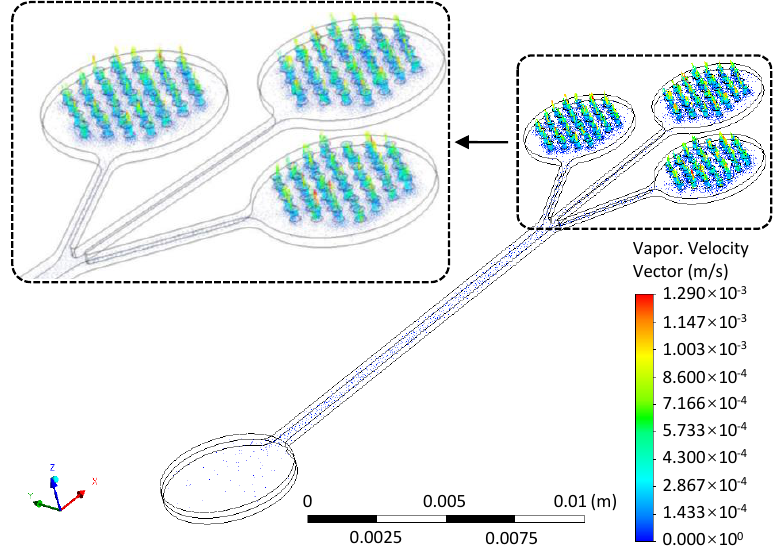
Figure 4. Vector of evaporation velocity at the whole fluid domain and at the outlet cavities (upper